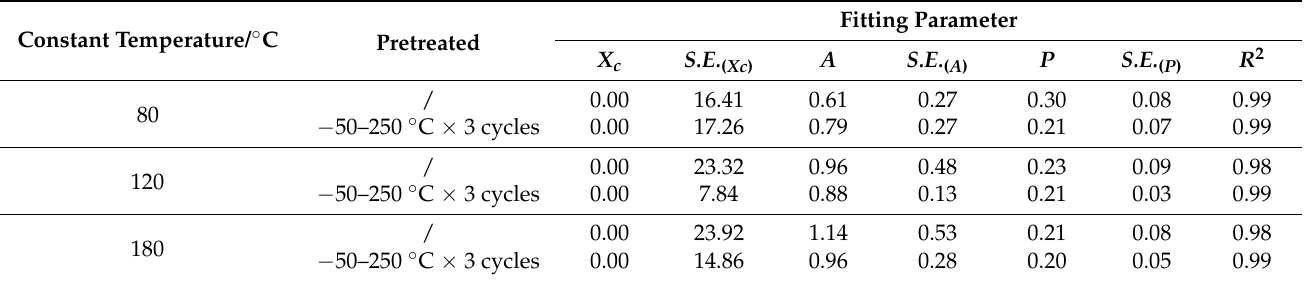
Table 5. Simulation results of the losses of Φ in the different constant temperatures after the 2000th, 3650th, and 6000th days by using the fitting parameters as shown in Table